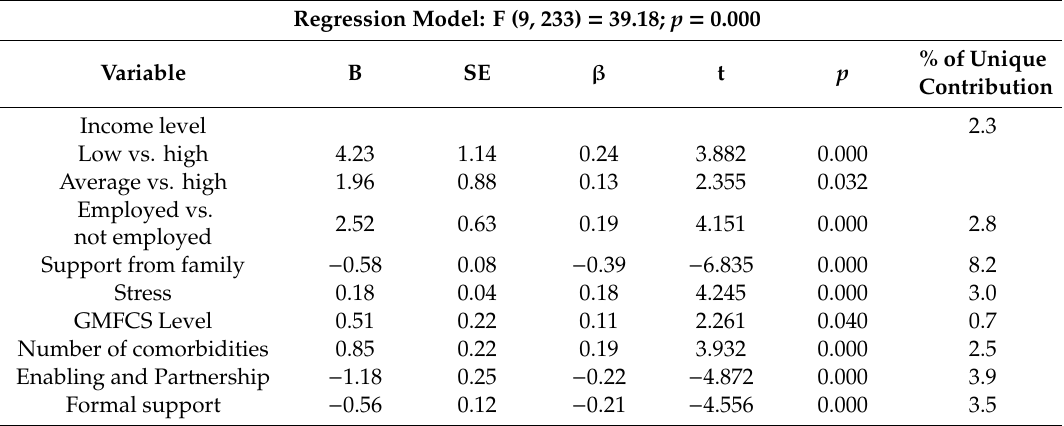
Table 11. Multiple regression model explaining overall family